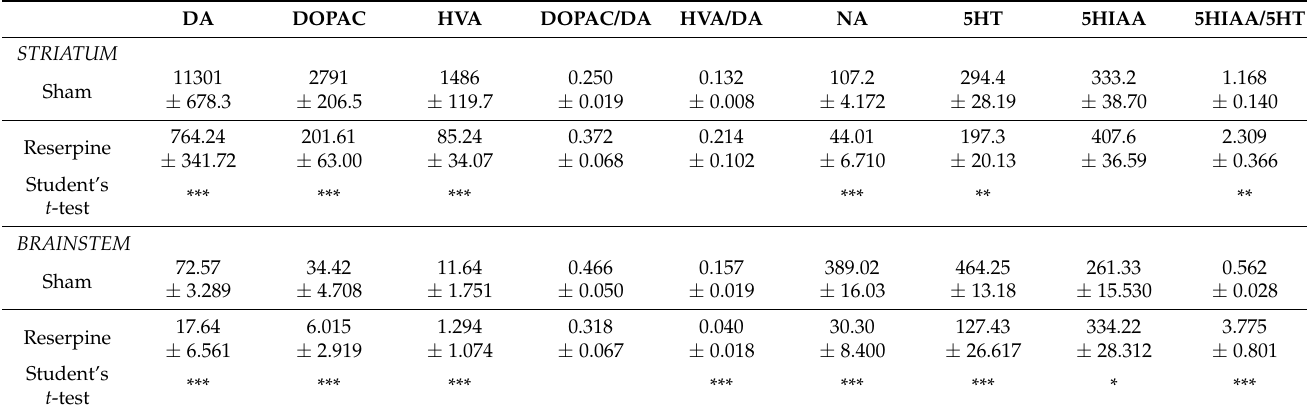
Table 1. Comparison of the amount of biogenic amines in the striatum and brainstem between reserpine and sham rats. The concentration of dopamine (DA), noradrenaline (NA), serotonin (5-HT), 3,4-dihydroxyphenylacetic acid (DOPAC), homovanillic acid (HVA), and 5-hydroxyindolacetic acid (5-HIAA) was assessed by HPLC detection ex vivo and expressed as pg mg − 1 of fresh